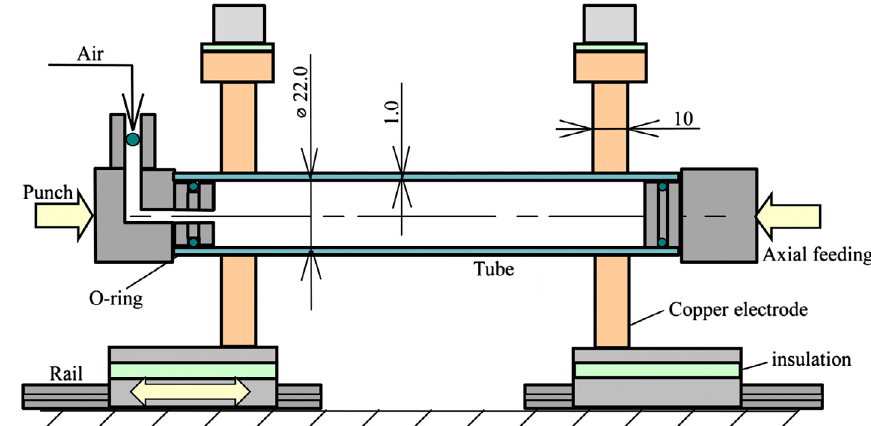
Figure 2. Experimental apparatus of hot bulging process of sealed aluminium alloy tube using resistance heating.